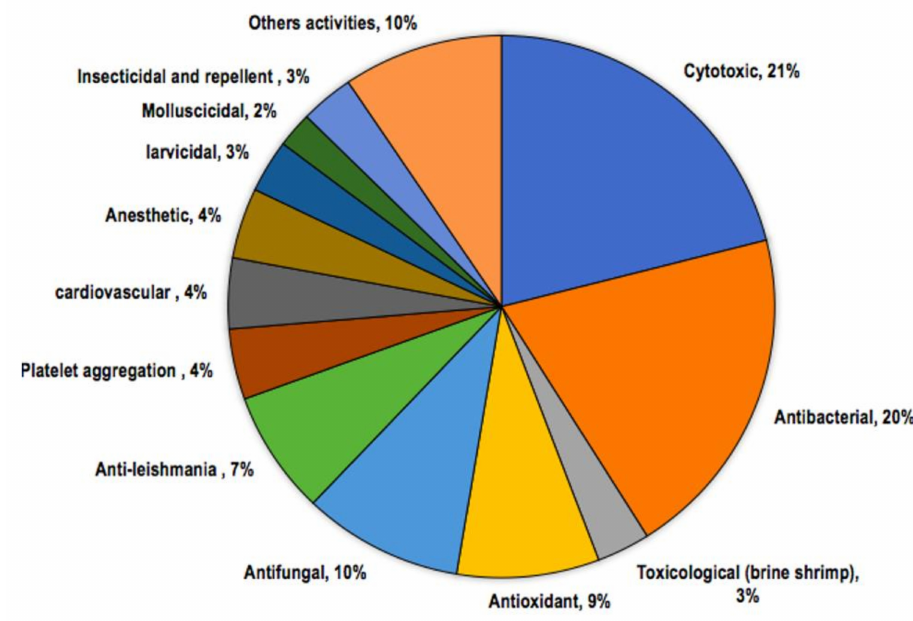
Figure 4. Distribution of studies on biological activities of EO from Licaria , Nectandra and Ocotea specimens with occurrence in